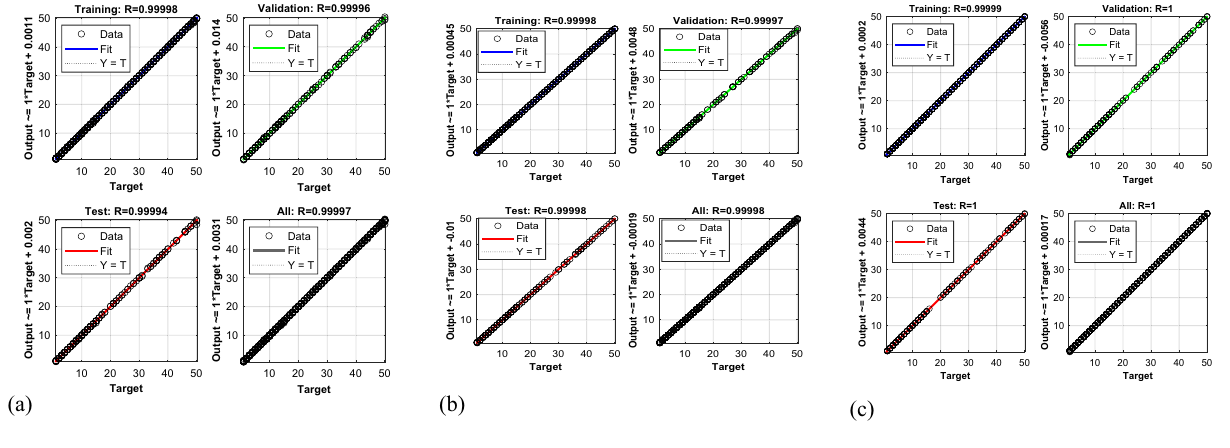
Figure 7. R -values: ( a ) ANN; ( b ) ANNPSO; ( c )